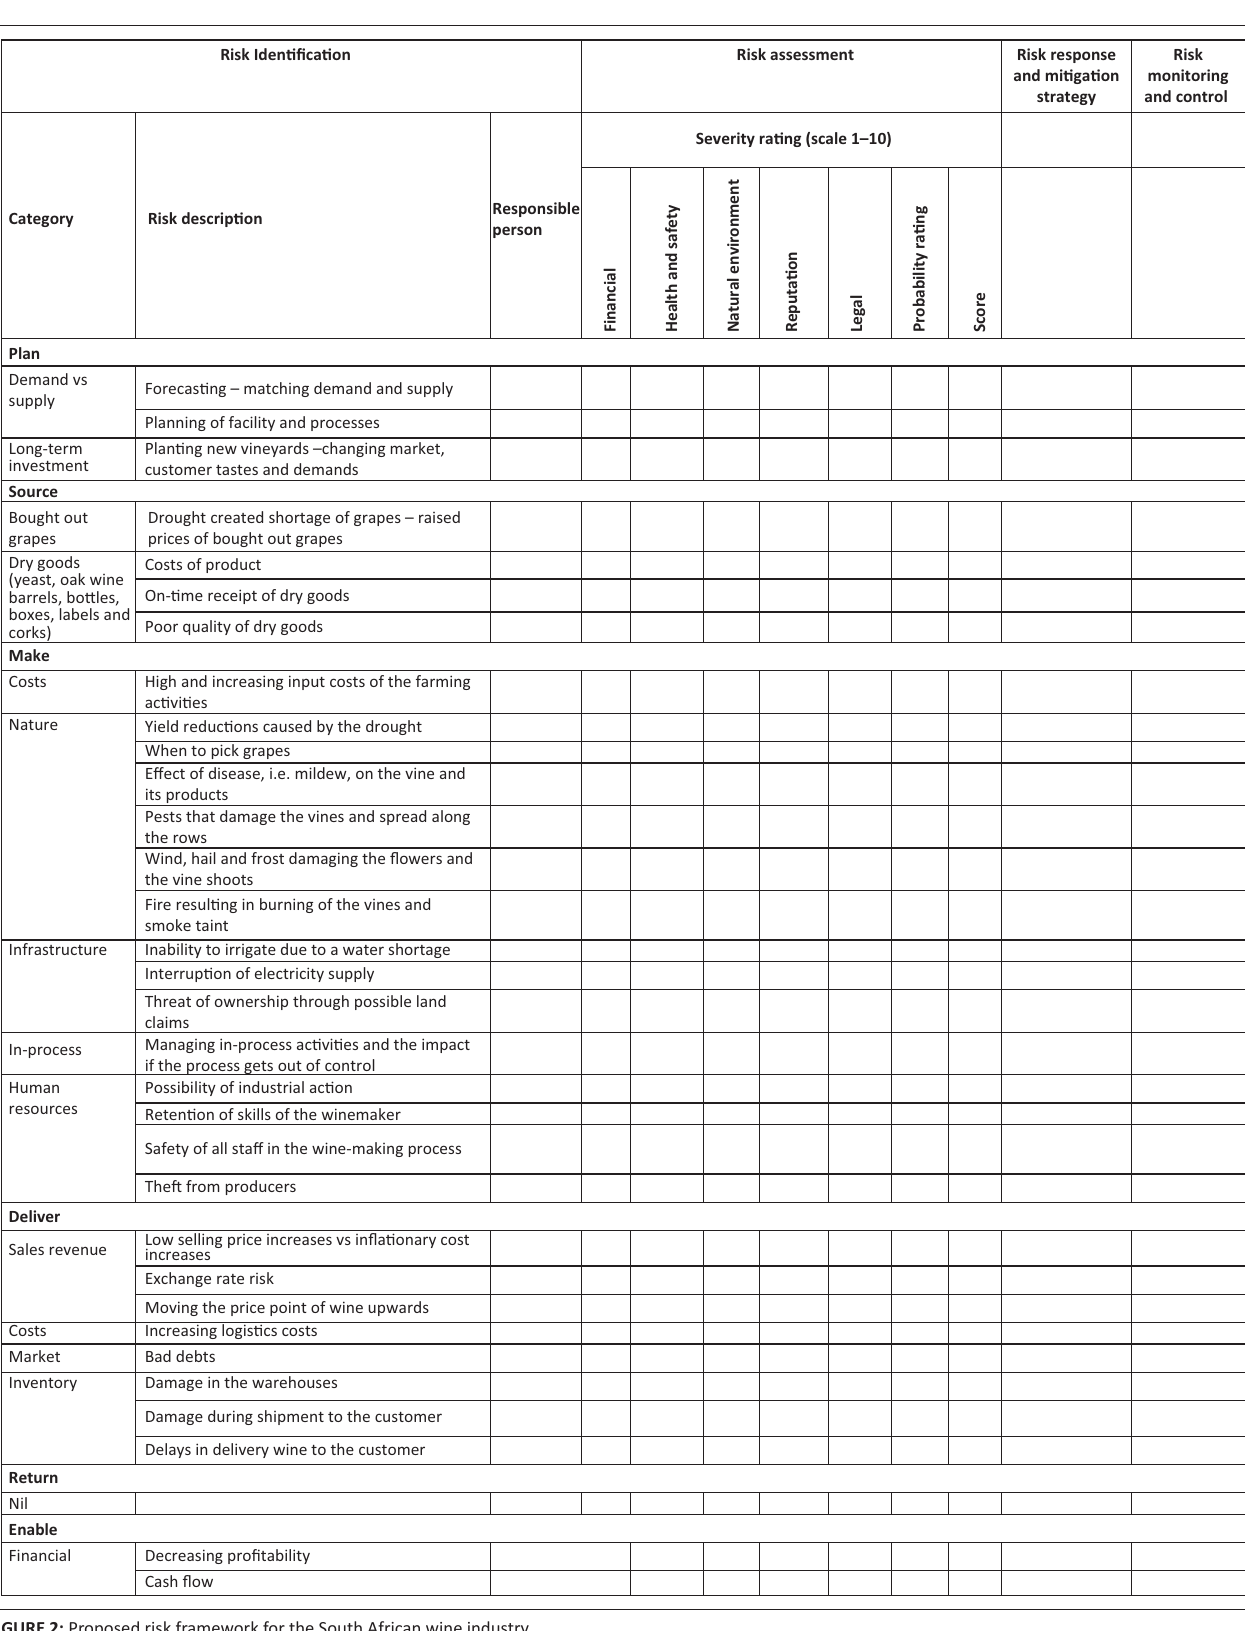
FIGURE 2 : Proposed risk framework for the South African wine